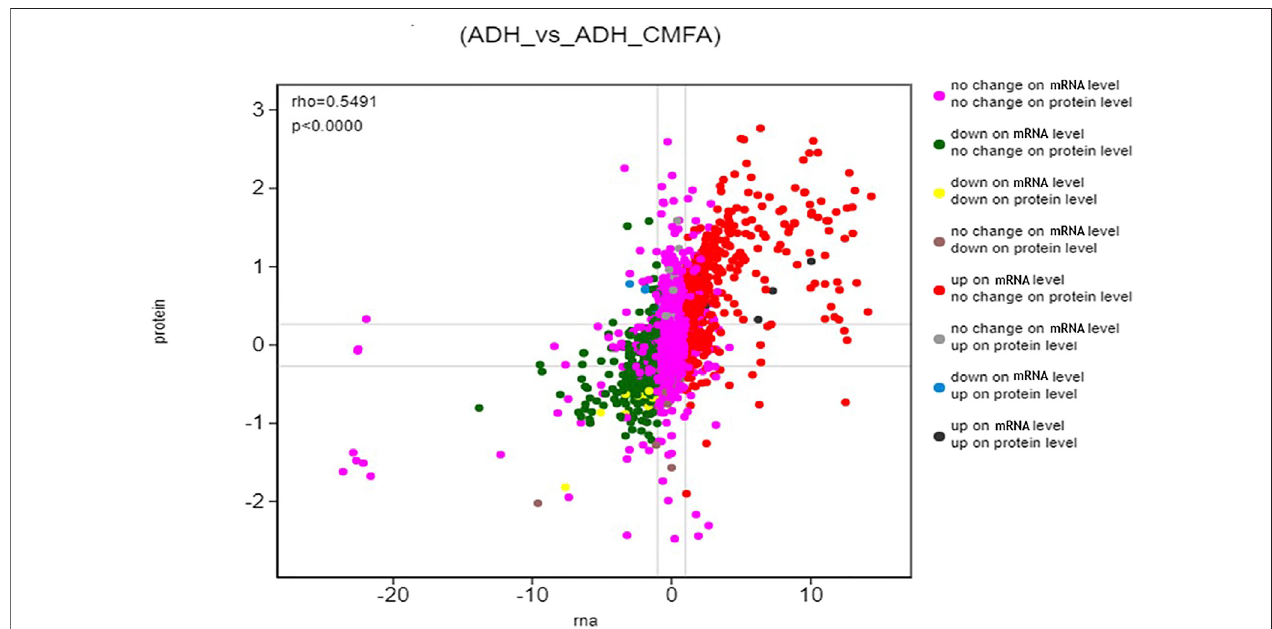
FIGURE 4 | Differential expression analysis (ADH_vs_ADH_CMF) The ordinate represents the expression multiple difference of the protein in a pair of comparison groups,thelog2(ratioofprotein).Theabscissarepresentstheexpressionofmultipledifferenceofthecorrespondingtranscriptinthecomparisongroup,thelog2(ratioof gene), logarithm difference takes the logarithmic value respectively; each point represents a protein and its associated transcript, the upper left corner of the picture rho represents the Pearson correlation coef fi cient between the two groups, p represents the correlation test p value; rho < 0 indicates negative correlation. rho > 0 indicates positive correlation; rho (cid:1) 0 indicates no correlation.